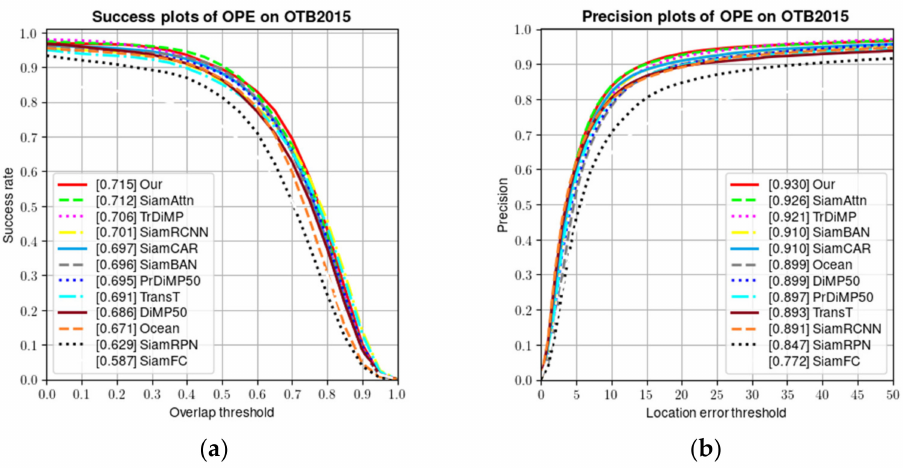
Figure 4. Comparison of the success rate and accuracy of the proposed algorithm with baseline algorithm and other advanced tracking algorithms. ( a ) success plots; and ( b ) precision